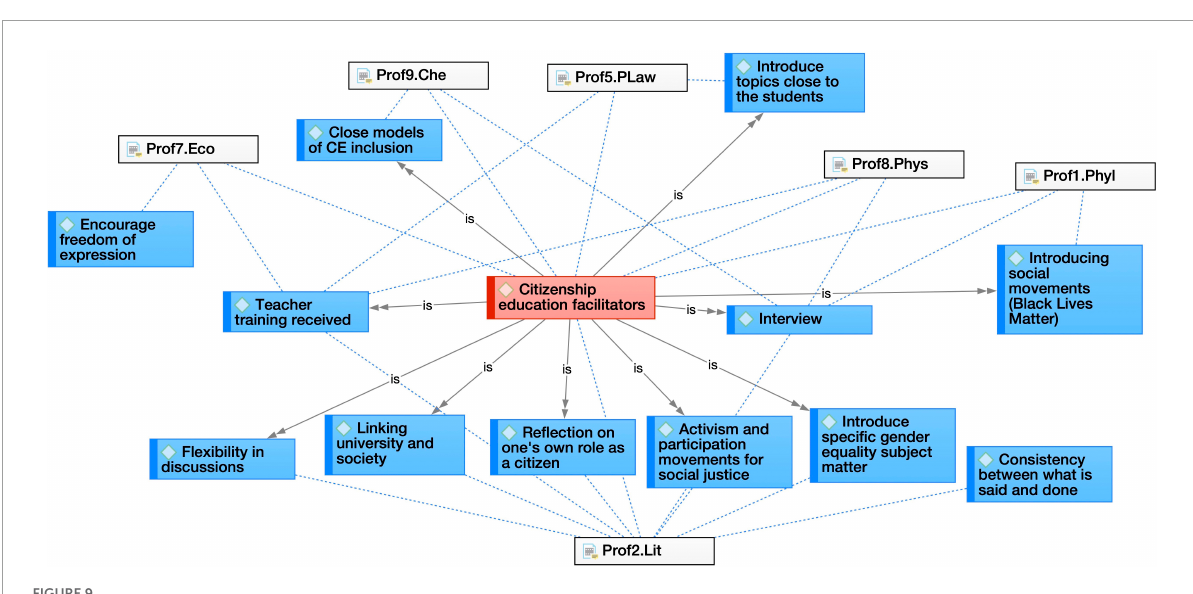
FIGURE9 Reported